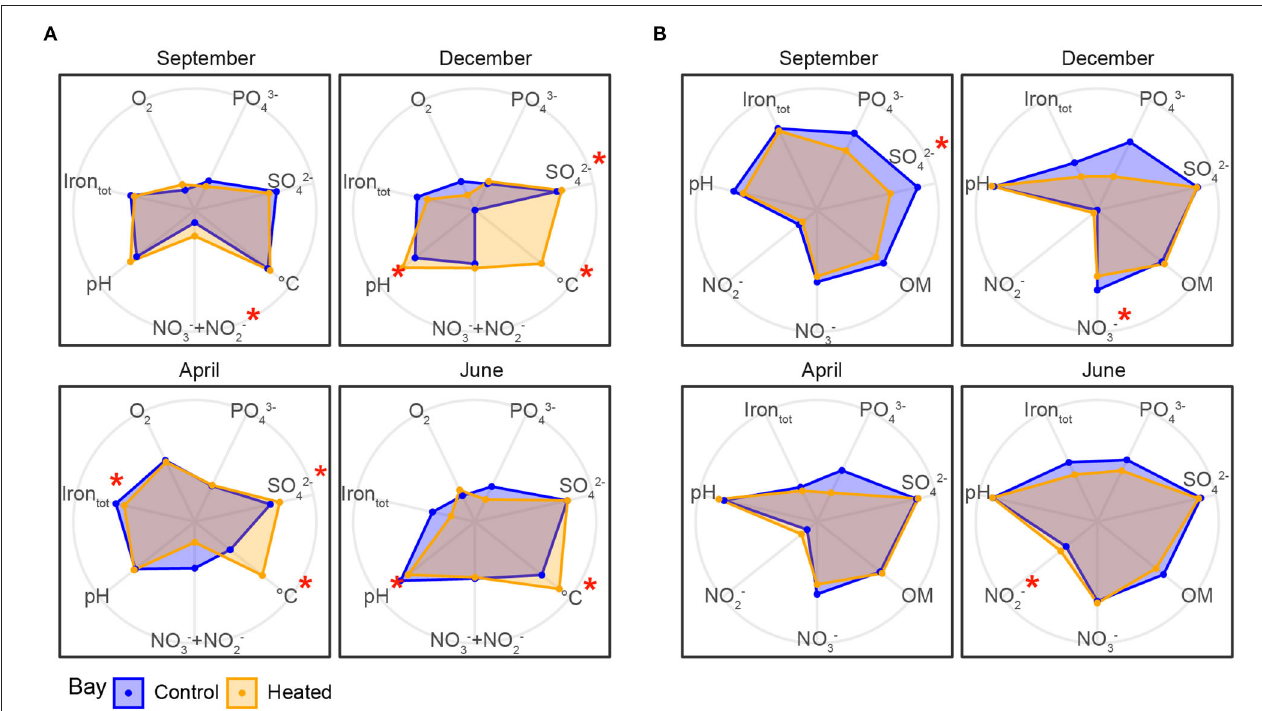
FIGURE 2 | Geochemical parameters in the heated (orange) and control (blue) bays in bottom water and sediment pore water over the four different sampling occasions. Geochemical parameters were measured in the bottom water (A) and sediment pore water (B) in the two bays between September 2017 and June 2018 (total 24 pore water samples from 0 to 1cm sediment and 24 bottom water samples per bay for each month, n = 192 for both bottom and pore waters). Radar plots were created with R using log 10 scale grouped by bays. Significantly different environmental variables between the bays are marked with a red asterisk. Low values of the environmental variables are closer to the center of the radar plot, while higher concentrations are further toward the edges; values were rescaled using the “rescale” function of